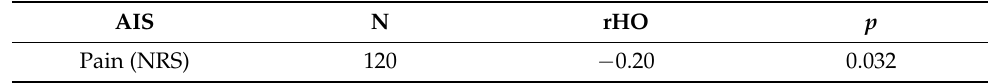
Table 12. Satisfaction with life versus pain